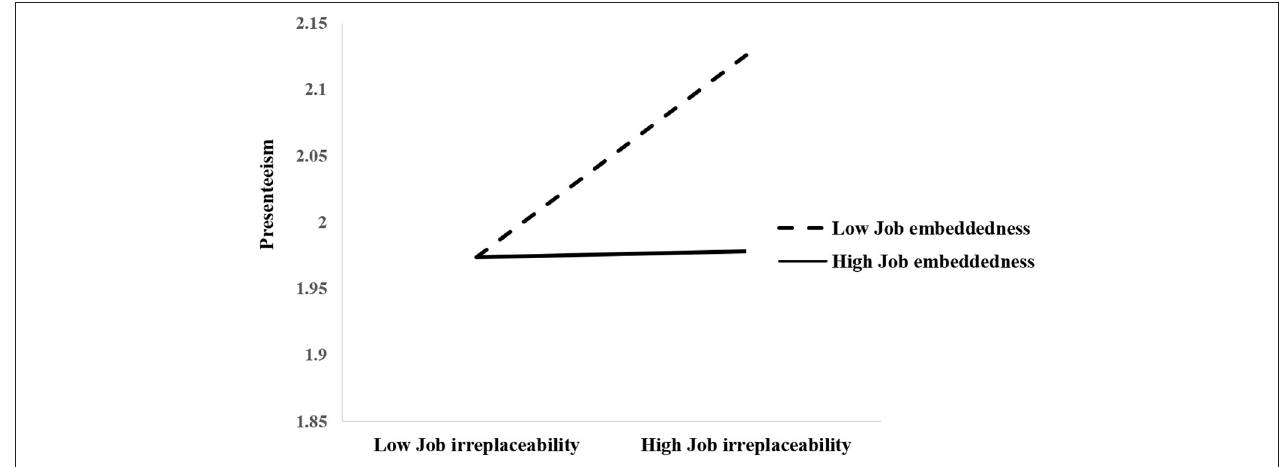
FIGURE 2 | Moderation effect of job irreplaceability between job embeddedness and presenteeism.